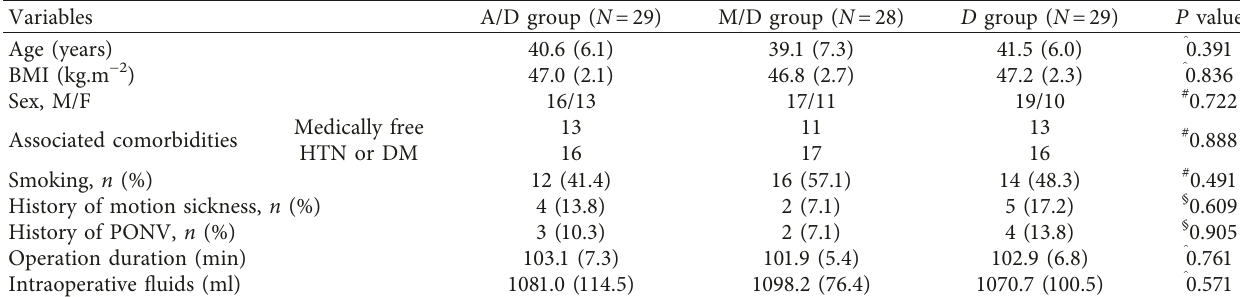
Figure 1: Flow chart of the study. A/D group: aprepitant/dexamethasone group, M/D group: mirtazapine/dexamethasone group, and D group: dexamethasone group. Table 1: Baseline characteristics among the studied